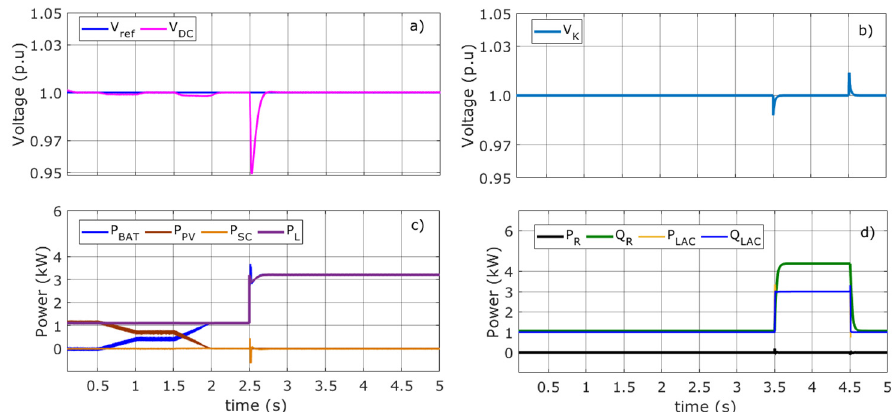
Figure 6. Voltage and power in Mode 1. ( a ) Reference and DC bus voltage ( b ) AC voltage ( c ) Battery, photovoltaic, SC, and load powers ( d ) Active and reactive VSC powers, active and reactive load powers.